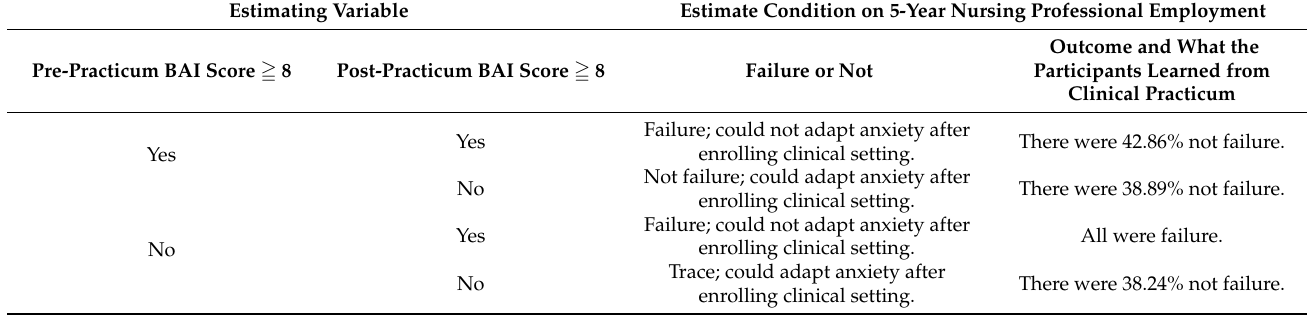
Table 4. Summary of 5-year nursing professional employment of low emotional stability with the estimating variable ( n =